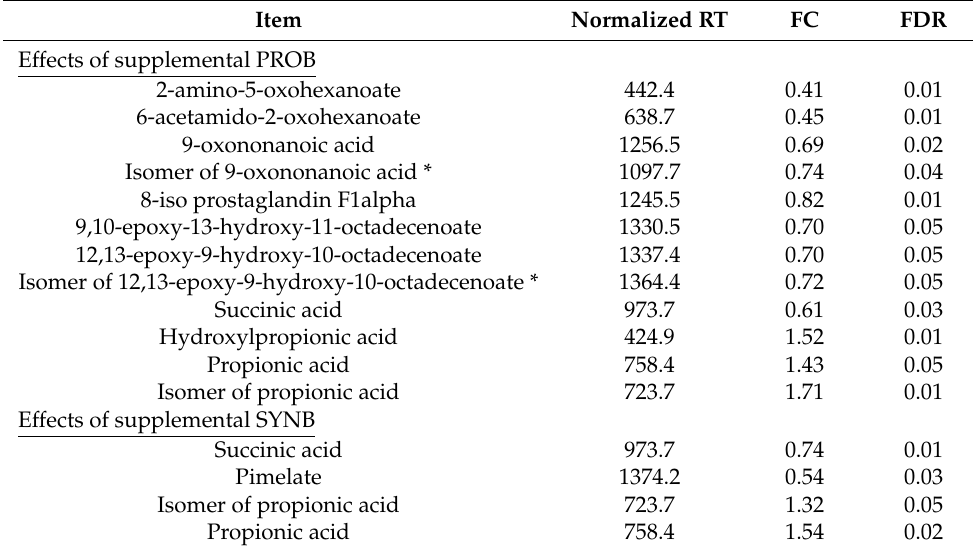
Table 2. Identified ruminal metabolites that were altered in beef steers fed diets supplemented with direct-fed microbials containing multiple microbial species and their fermentation